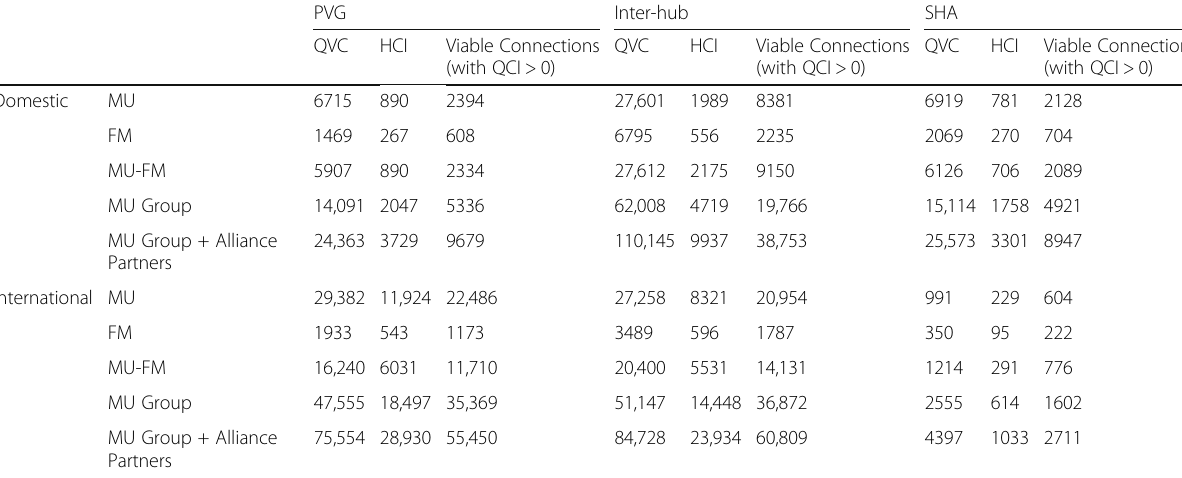
Table 4 Dual-hub connectivity of MU Group and alliance partners